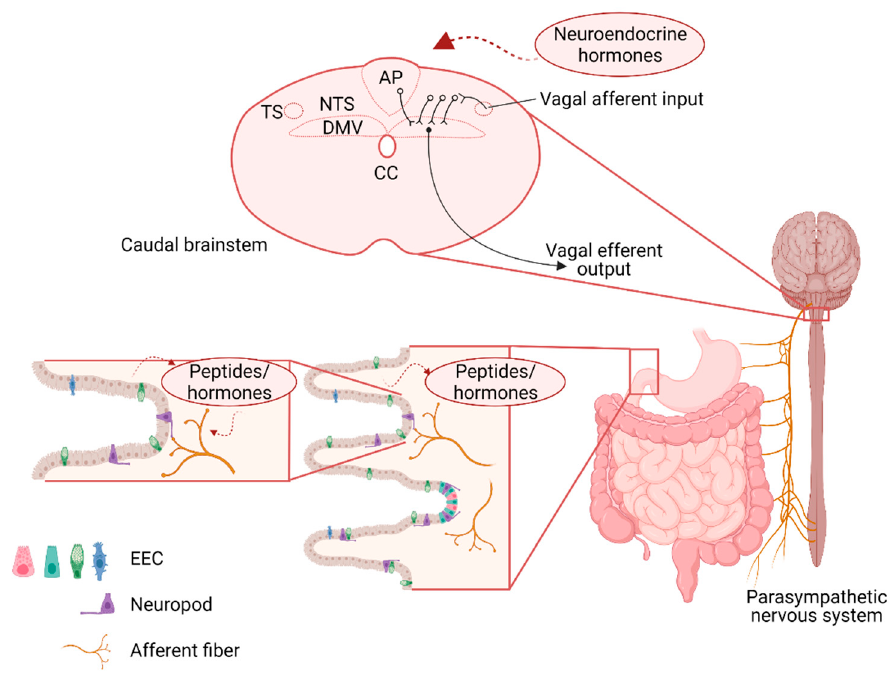
Figure 1. Schematic representation of the neuroanatomical connections between the gastrointestinal (GI) tract and brainstem vagal nuclei involved in the regulation of food intake. Sensory information from the GI tract is relayed centrally via the afferent vagus which responds both directly (via neuropods) and indirectly (via paracrine signaling) to gastrointestinal stimulation. At the level of the dorsal hindbrain, afferent vagal inputs enter the brainstem via the tractus solitarius (TS) and terminate on neurons of the nucleus of the tractus solitarius (NTS). The integrated signal is relayed from the NTS to the adjacent dorsal motor nucleus of the vagus (DMV) via catecholaminergic, glutamatergic, and predominantly gamma aminobutyric acid (GABA)-ergic, synapses. The DMV contains preganglionic parasympathetic motoneurons that relayed the resulting output signal to the GI tract via the efferent motor vagus. EEC—enteroendocrine cells; CC—central canal.